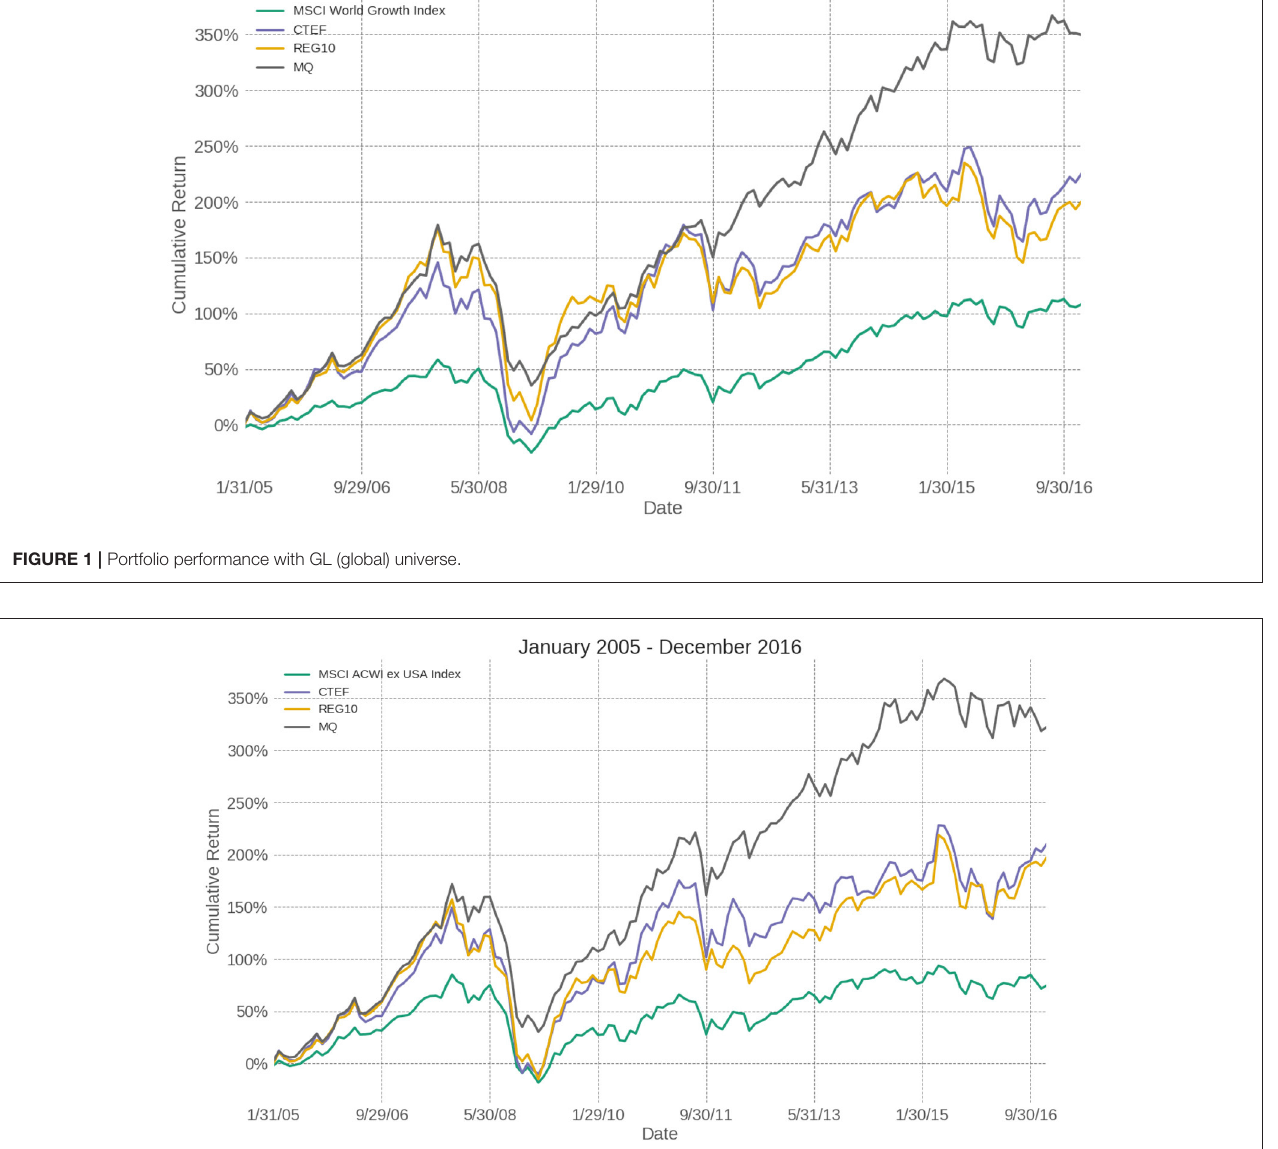
FIGURE 2 | Portfolio performance with XUS (non-US)